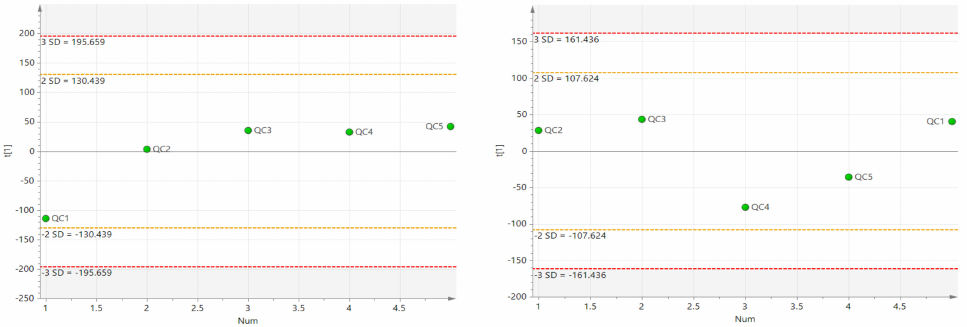
Figure 2. QC sample PCA score chart (Right: Negative ion mode; Left: Positive ion